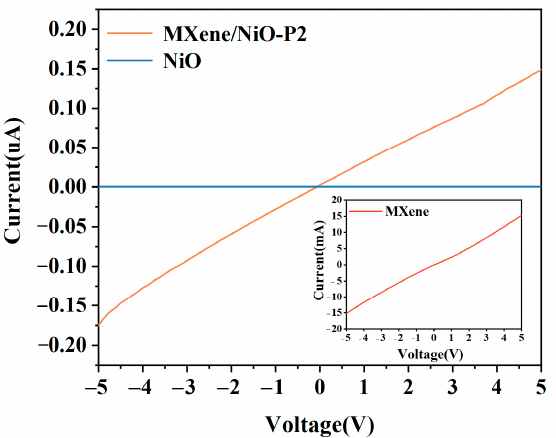
Figure 5. I-V curves of the sensors based on MXene/NiO-P2, NiO, and MXene. The real-time resistance changes in the MXene/NiO-P2-based chemiresistive-type sensor to 10–100 ppm HCHO at 25 °C and RH = 40% is shown in Figure 6a. When the sensor was exposed to reductive HCHO gas, the resistance of the sensor rose sharply.